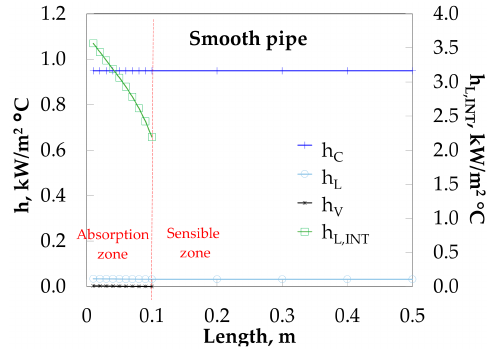
Figure 8. Heat transfer coefficient profiles along bubble absorber